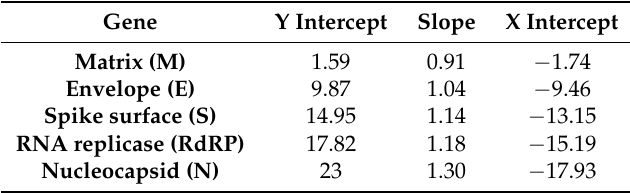
Table 4. Parameters of the linear regressions in Forsdyke plots. None of these plots intersect. The value of each parameter increases from M (lowest) to N (highest). Negative x values indicate flexibility to respond to global pressure to change DNA sequence (virtual time axis) in order to prevent recombination, and to thus allow species divergence (i.e., generate SARS-CoV-2). When recombination is still possible, then two diverging genomes in the same cell will blend, so militating against protein differentiation would occur in time, corresponding to positive x values.